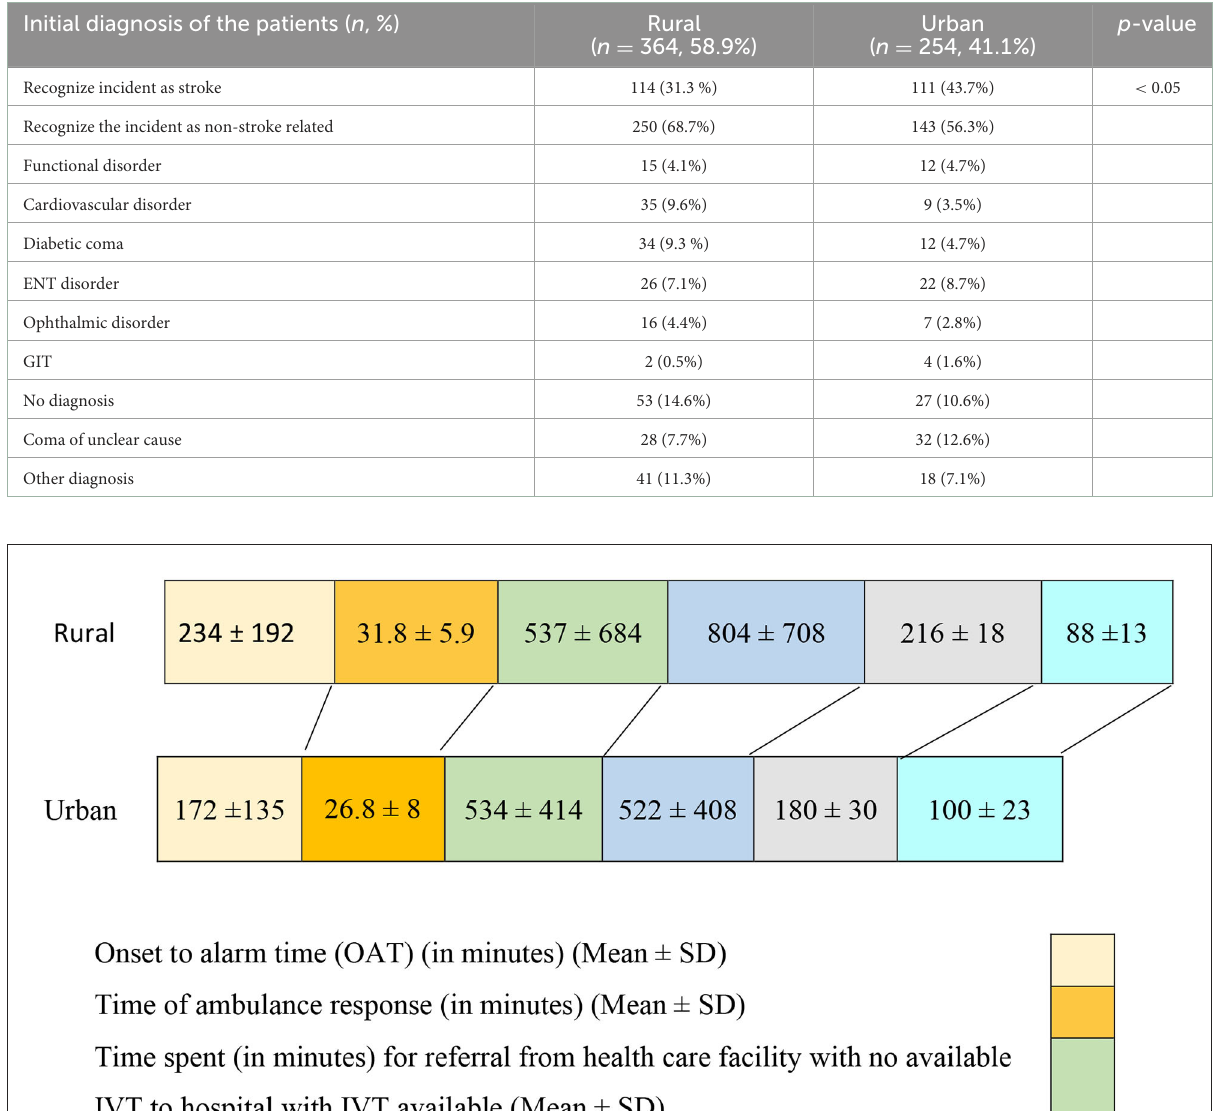
TABLE 3 Accuracy of stroke diagnosis variations among rural and urban regions. Initial diagnosis of the patients ( n , %) Rural